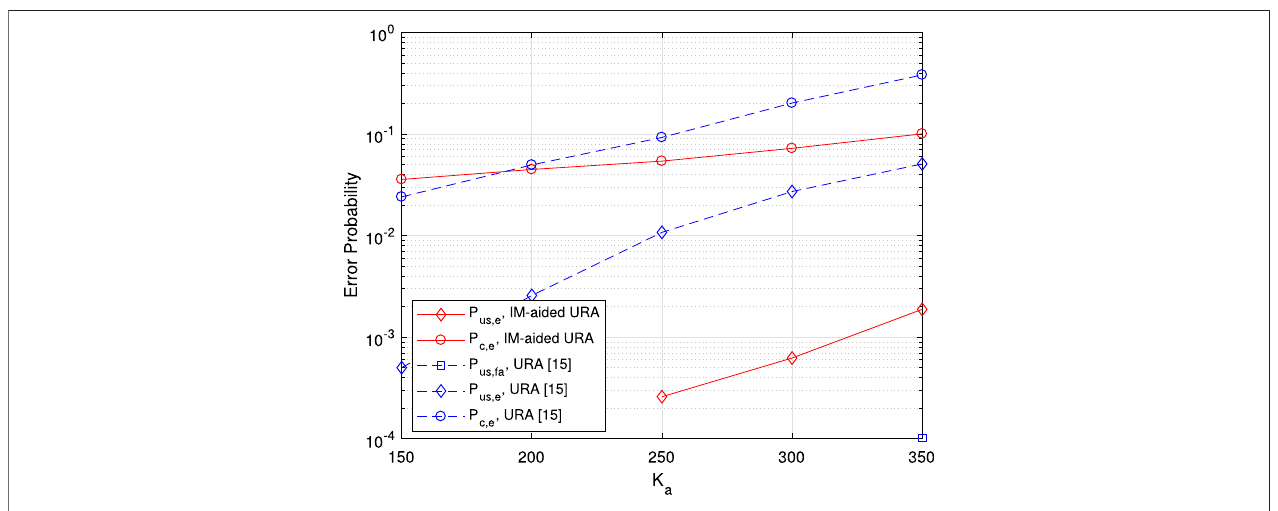
FIGURE8| Error probability vs.thenumberofactive users K a .Here,the number of BS antennas is M (cid:1) 300. The channel block length is fi xed at L (cid:1) 100. For user-speci fi c information, misdetection and false alarm are not observed in both schemes.